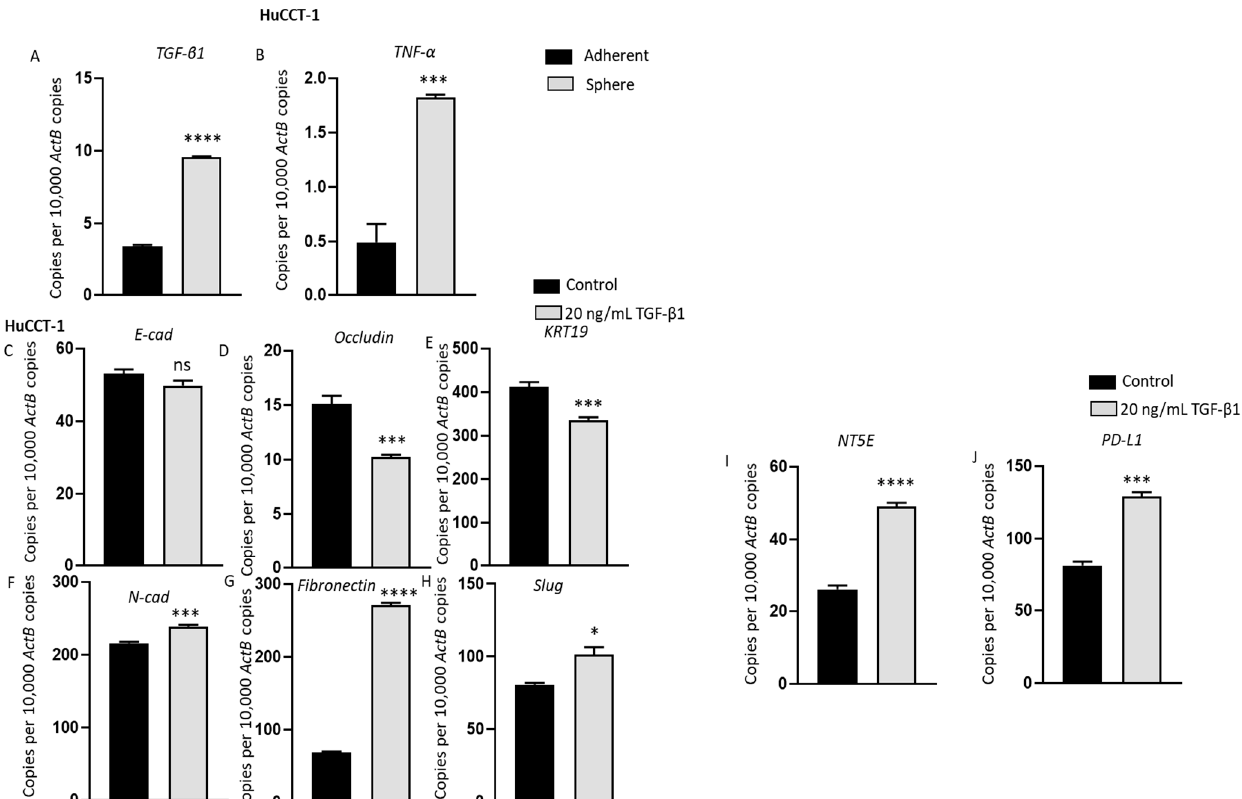
Figure 7. TGF- β 1-mediated EMT induced upregulation of immune modulators in HuCCT-1 cells. qRT-PCR analysis revealed the upregulation in the expression of ( A ) TGF- β and ( B ) TNF- α in HuCCT-1 spheres compared with parent adherent cells. ( C – H ) qRT-PCR showed epithelial markers E-Cad, Occludin and KRT19 were decreased, and mesenchymal markers N-cad, Fibronectin and Slug were increased after 72 h of TGF- β 1 treatment in HuCCT-1 cells. ( I – J ) qRT-PCR demonstrated elevated expression of immune modulators NT5E and PD-L1 upon 72 h of TGF- β 1 treatment in HuCCT-1 cells. Values are mean ± SD of three experiments in triplicate (* p < 0.05, *** p < 0.005, **** p < 0.001, ns: not significant). ActB: β -Actin .